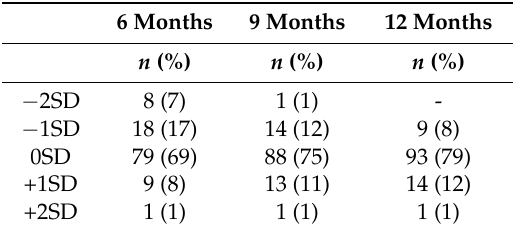
Table 4. BMI z -scores distribution at 6, 9 and 12 months of age ( n = 115 at 6 months; n = 117 at 9 and 12